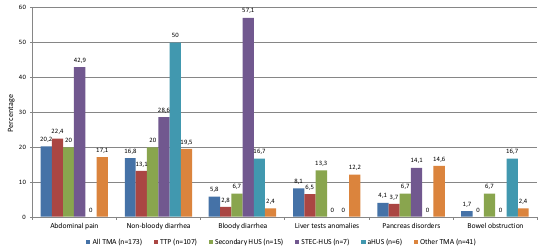
Fig. 1 Relative frequencies of digestive manifestations in 173 critically ill TMA